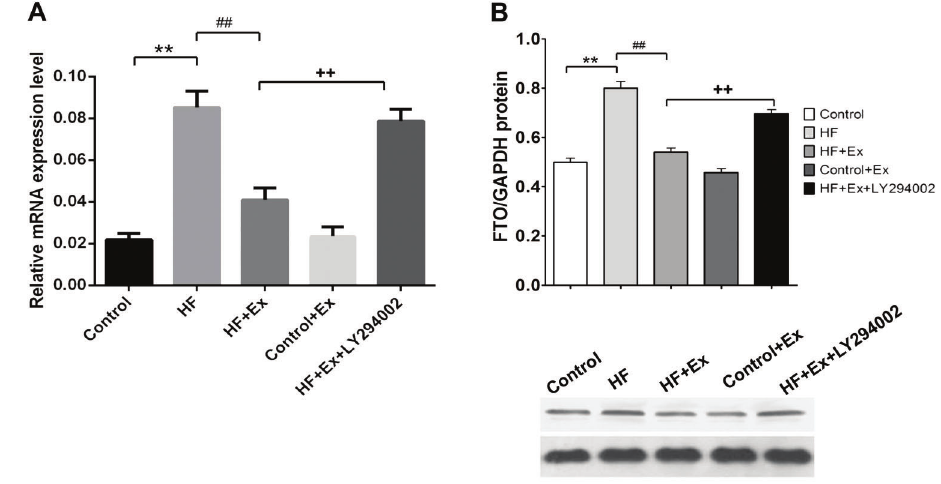
Figure 7. PI3K inhibitor LY294002 partially reversed exenatide (Ex)-dependent inhibition of palmitic acid-induced mass and obesity associated ( FTO ) gene expression in L02 cells. Total RNA and protein were extracted from L02 cells treated in each group and used to assess A , FTO mRNA expression and B , FTO protein expression by qRT-PCR and western blot, respectively. Data were normalized relative to the GAPDH level for each sample and are reported as means ± SD (n=6). **P o 0.01 compared with the control group; ## P o 0.01 compared with the high fat (HF) group; ++ P o 0.01 compared with the HF + Ex group (paired t